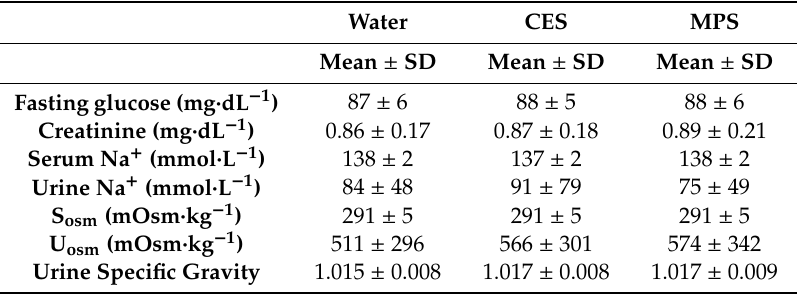
Table 3. Baseline Characteristics by